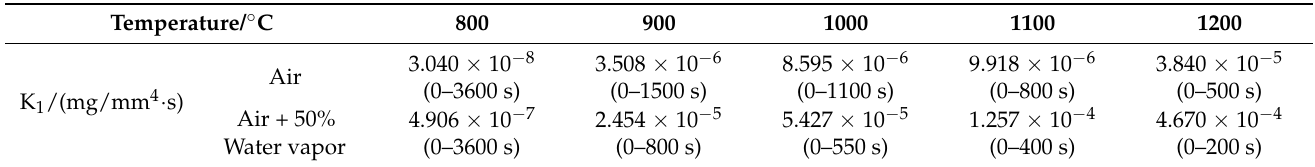
Table 4. K 1 values of Fe–10Cr steel in air and 50% water vapor.